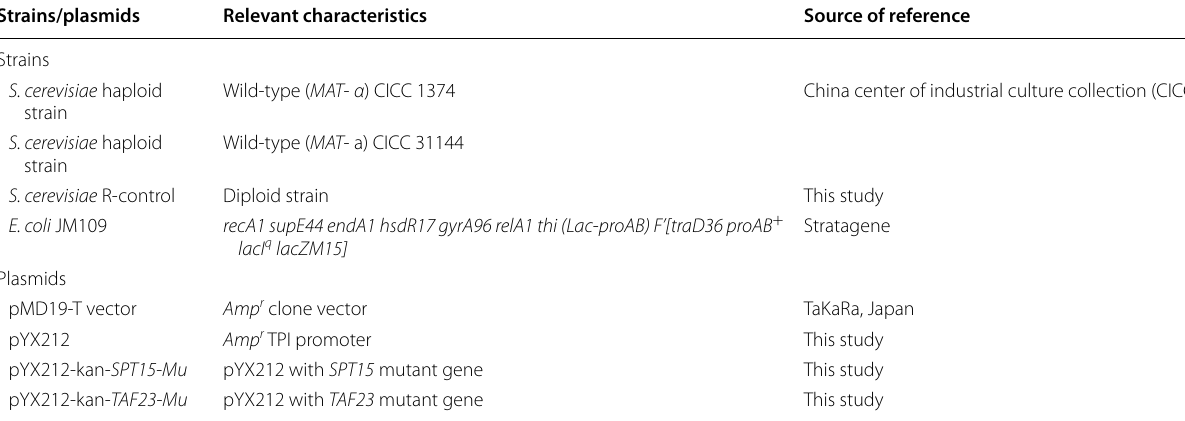
Amp r : ampicillin resistant, Kan: kanamycin